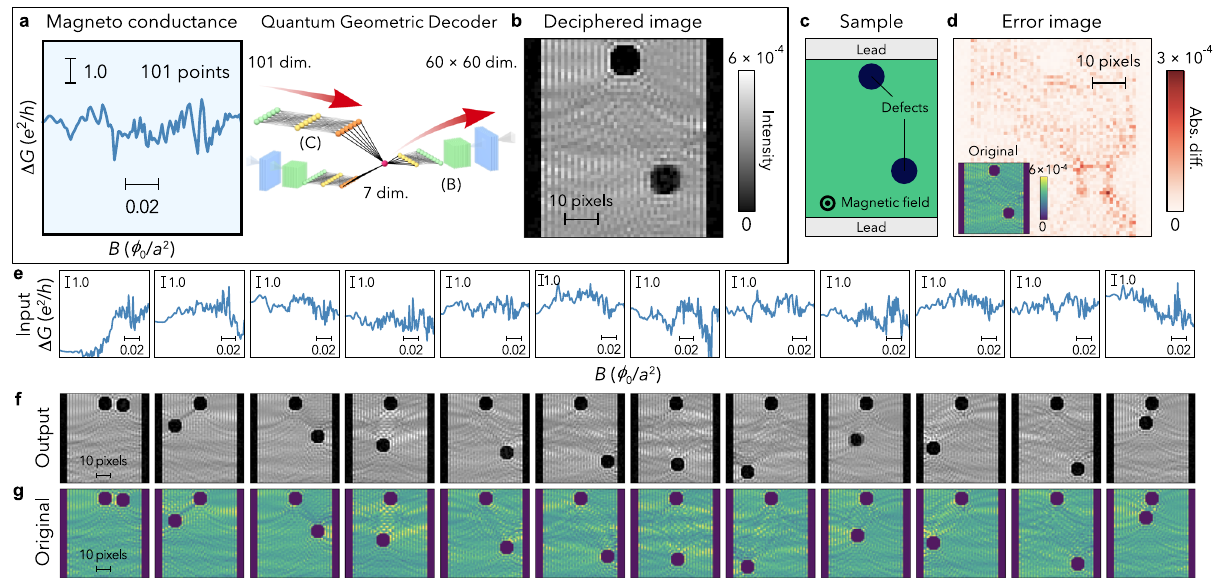
Fig. 4 Result of quantum geometric decoding (QGD). a , b The geometry generative network and an example of the input conductance and output deciphered image. Δ G and B are the normalised magneto-conductance and the magnetic fl ux density, respectively. c The sample system whose magneto- conductance is shown in a . d The absolute difference image between the original image (inset) and the output deciphered image shown in b . e , f , g Examples of the input conductance ( e ), output deciphered images ( f ), and original images ( g ). Colour scales of the intensity images in f and g are the same as those of b and the inset to d ,